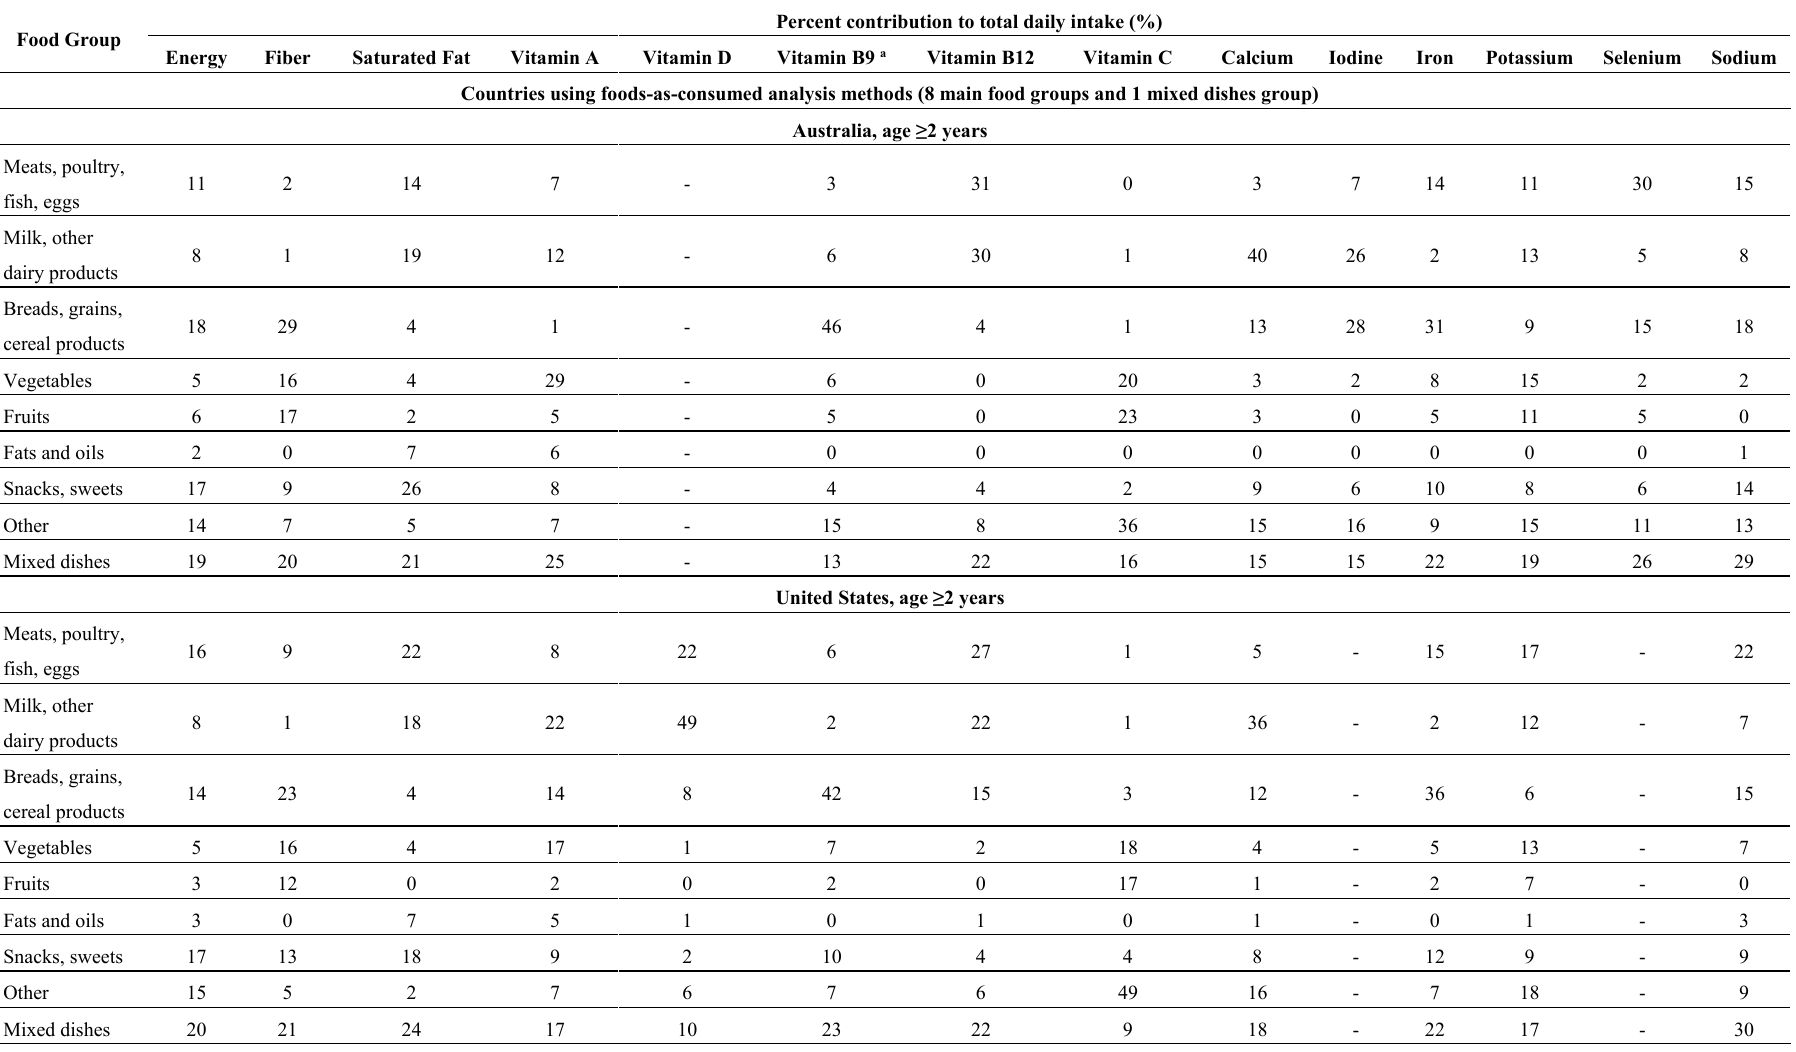
Table 4. Contribution of food groups to total daily energy and nutrient intakes in four developed countries, total